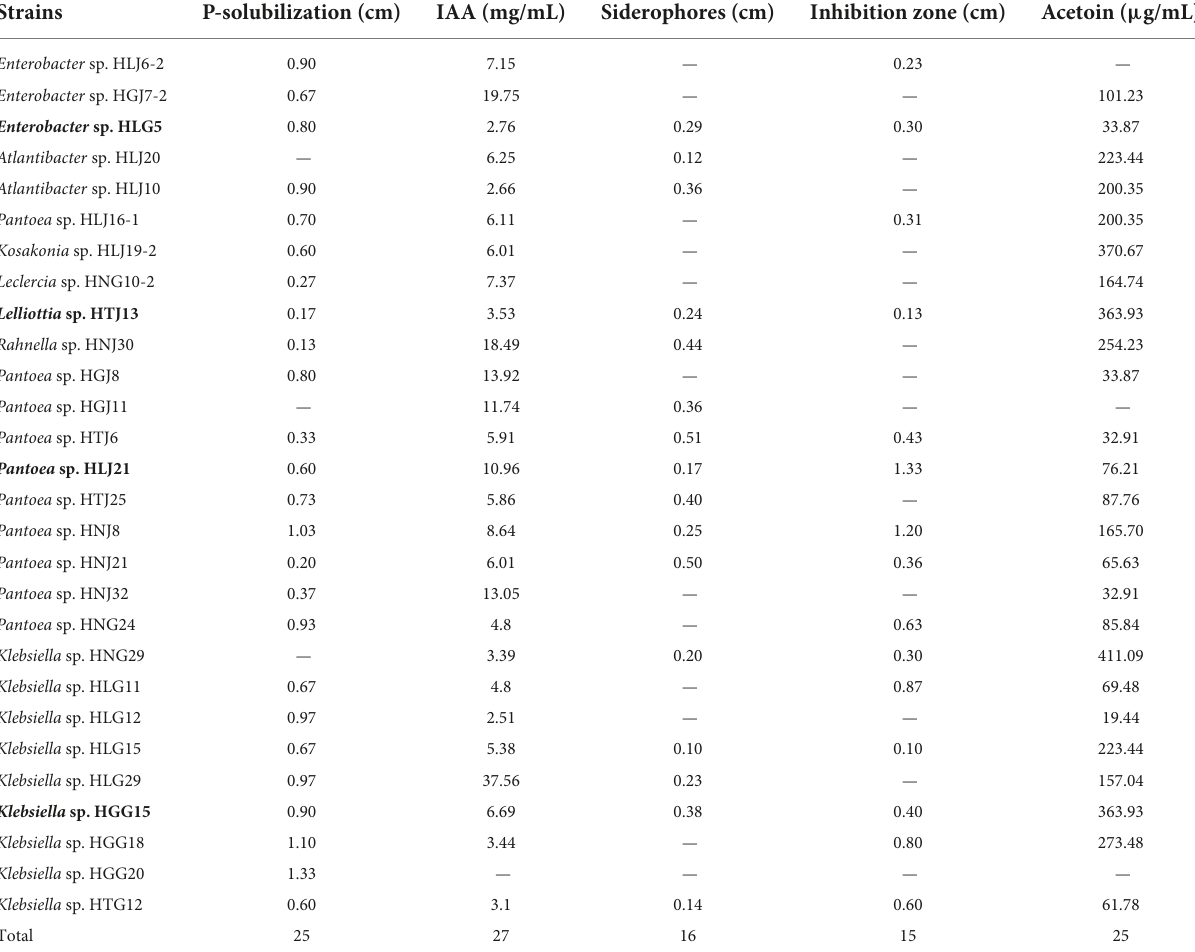
TABLE 1 Characterization of endophytic bacteria for potential plant growth-promoting traits.